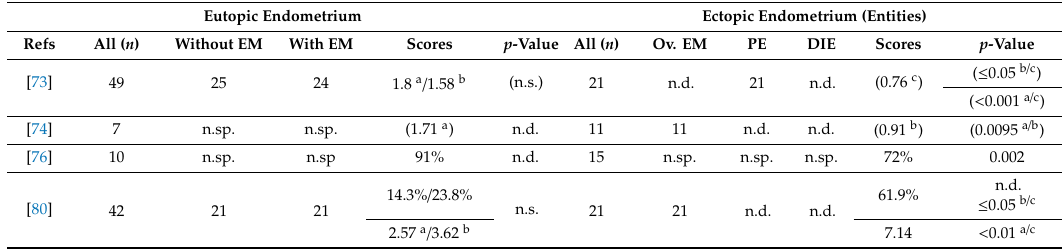
Table 2. Immunohistochemistry of β -catenin in eutopic and ectopic endometrium. Eutopic Endometrium Ectopic Endometrium